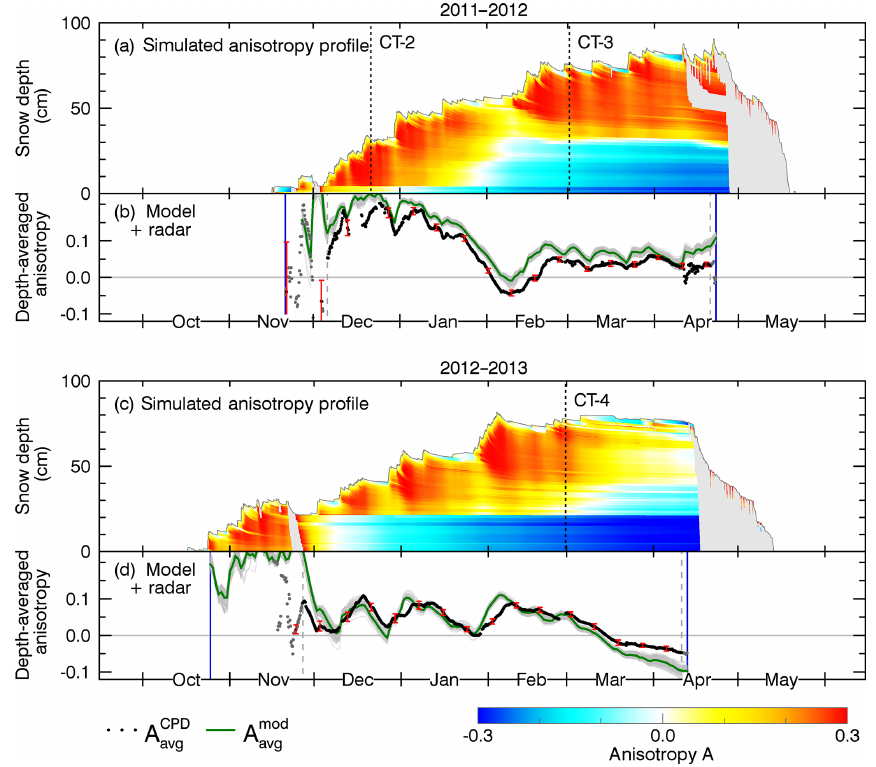
Figure 7. Structural anisotropy simulated for the seasons 2011/2012 and 2012/2013. Labels CT-2, CT-3, and CT-4 indicate the sampling dates of the CT validation data. Further descriptions are given in the caption of Fig. 6.